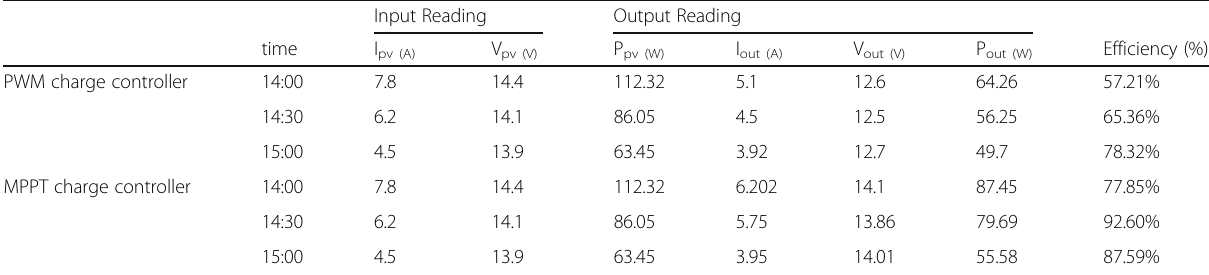
Table 2 Comparison of PWM and designed MPPT charge controller